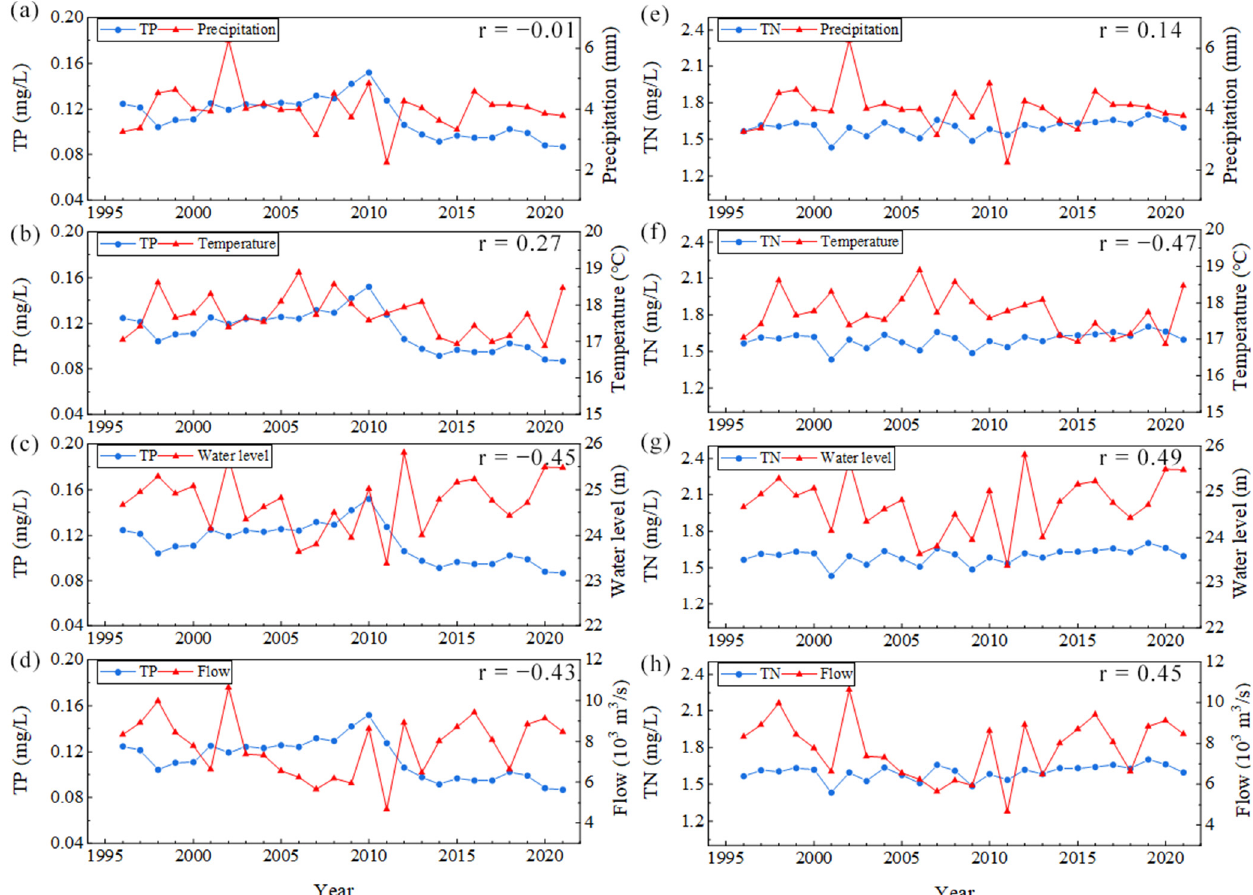
Figure 11. Annual time series of hydrometeorological elements and water quality parameters. ( a ) TP and Precipation, ( b ) TP and Tempreture, ( c ) TP and Water level, ( d ) TP and Flow, ( e ) TN and Precipation, ( f ) TN and Tempreture, ( g ) TN and Water level, and ( h ) TN and